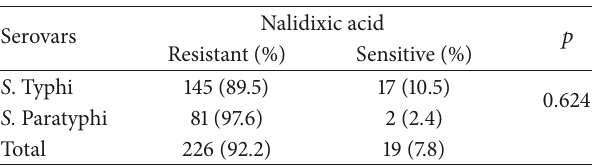
Table 3: Distribution of nalidixic acid (NA) resistant S. Typhi and S. Paratyphi